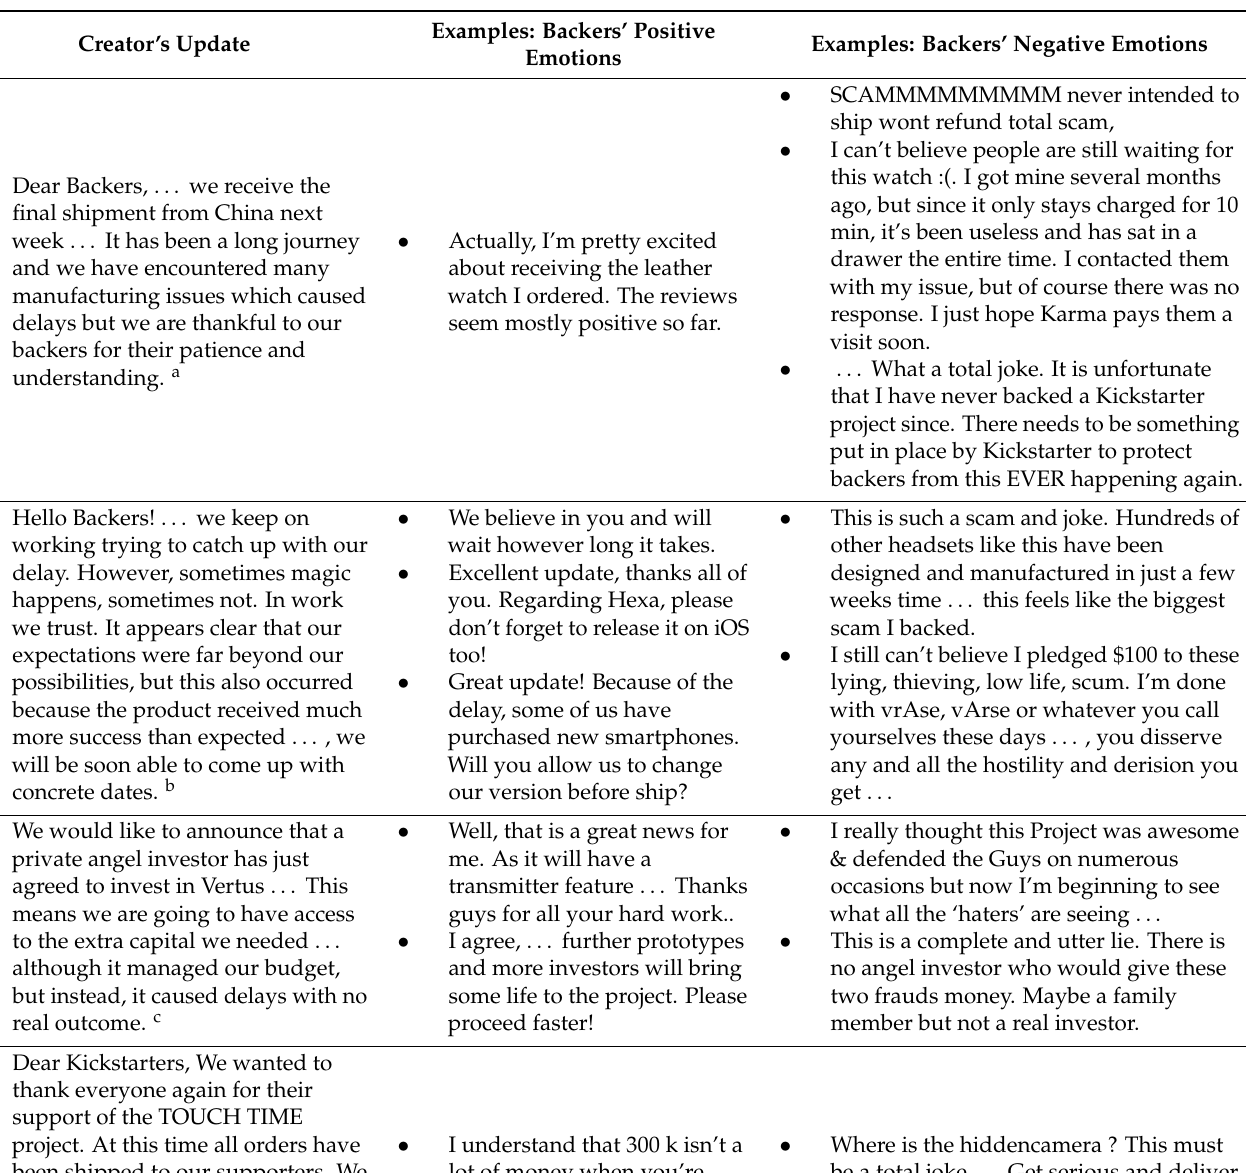
Table A1. Creators’ Update and Subsequent Backer Reaction (Selected